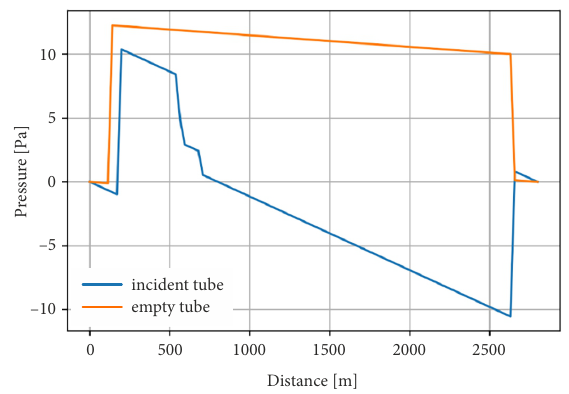
optimization of the